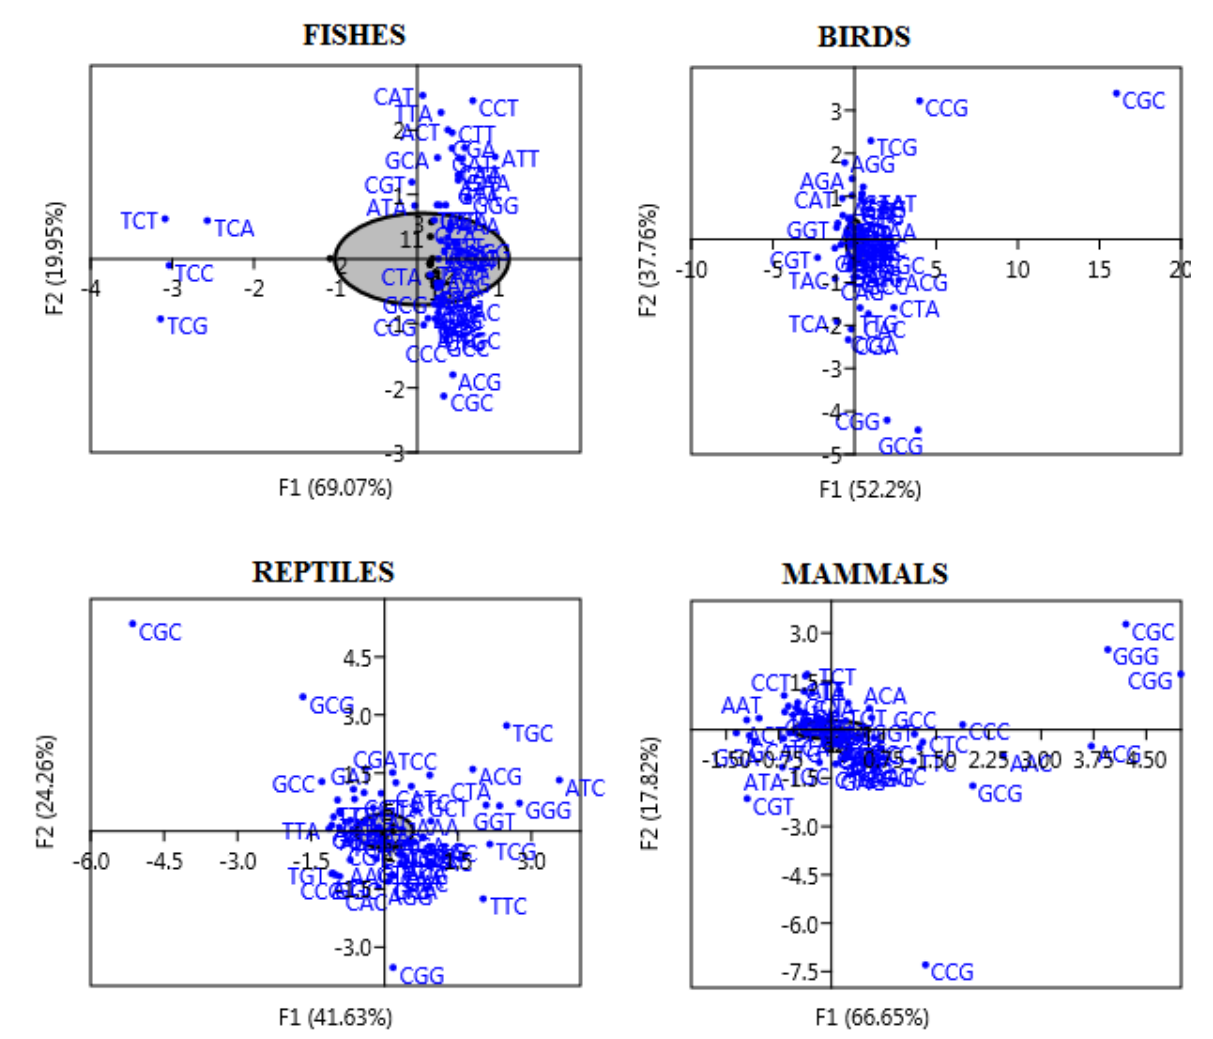
Figure 6. The correspondence analysis of RSCU values for Foxp2 gene in fishes, birds, reptiles, and mammals. In the plot, each of the points indicate the variation of genes corresponding to the coordinate of first ( f1 ) and second ( f2 ) axes of vari- ation.